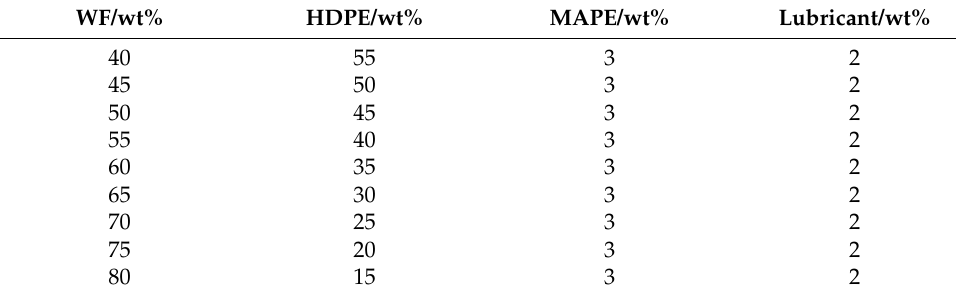
Table 1. Sample formulation of wood–plastic composites (WPCs).